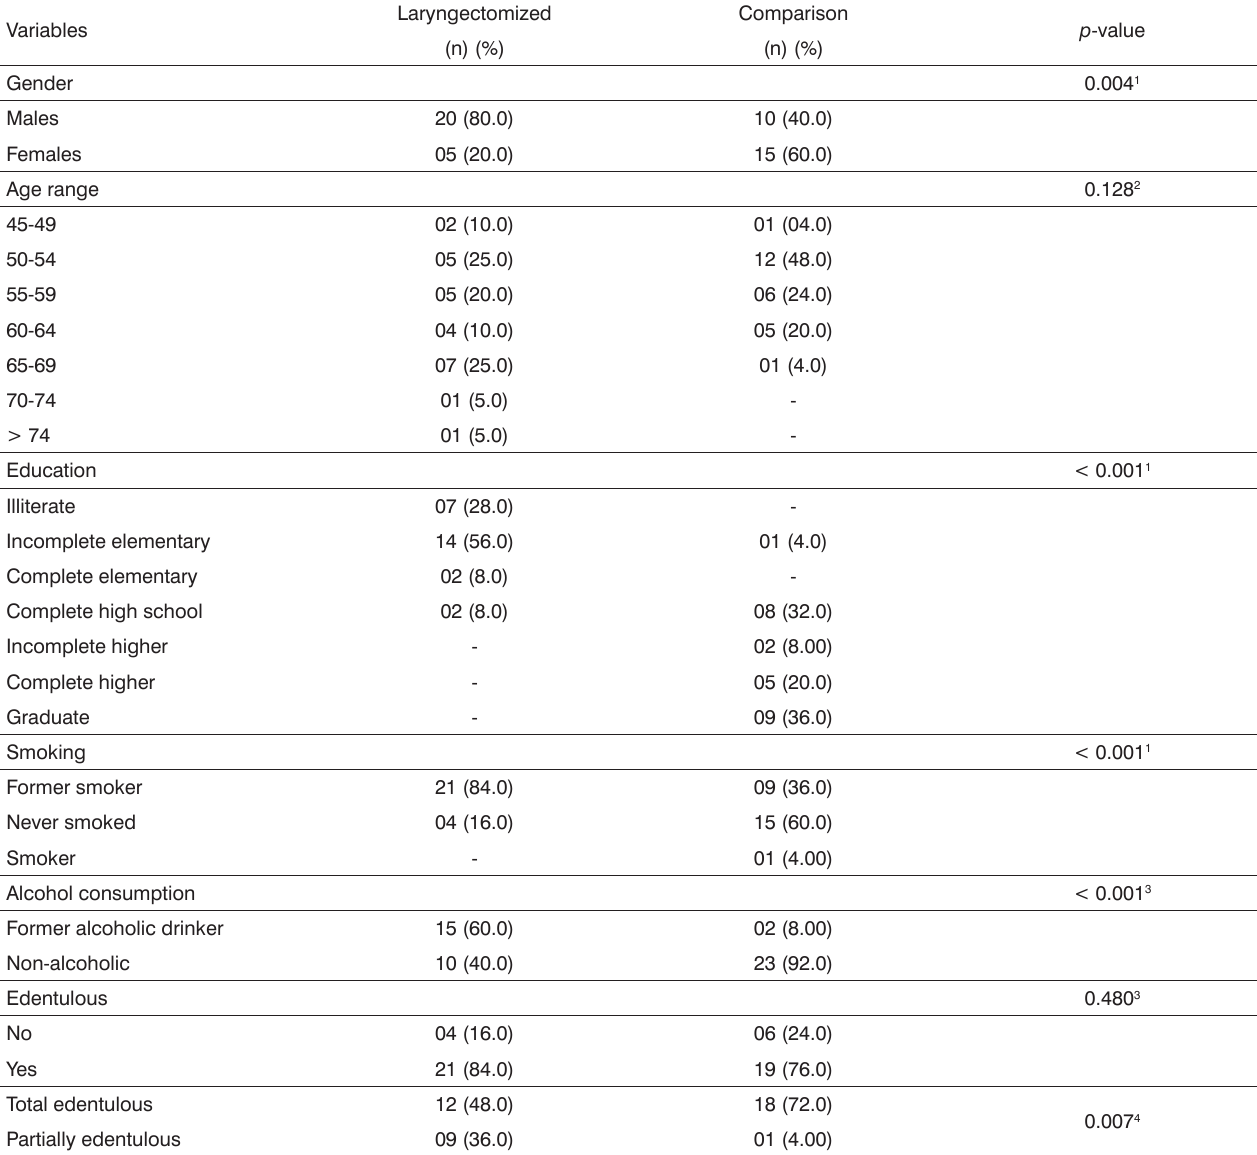
Table 1. Distribution of comparisons between the laryngectomized patients’ group and the comparison group by sampling describing